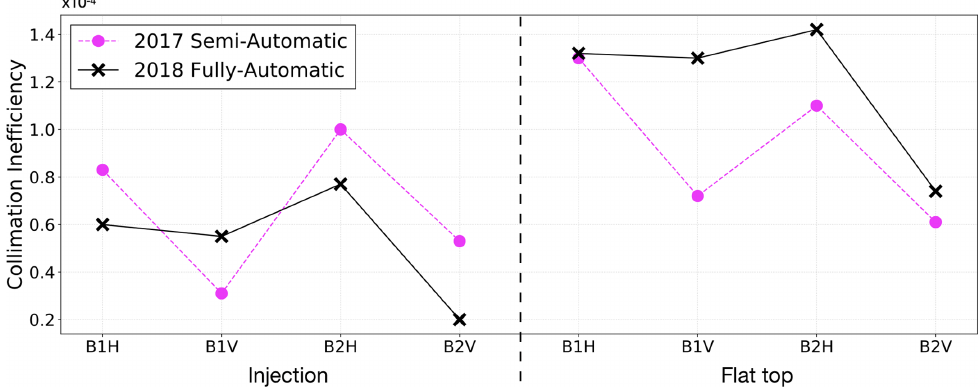
FIG. 11. Comparison of losses in the IR7 DS after commissioning using the fully automatic alignment in 2018 and the semiautomatic in 2017, extracted from